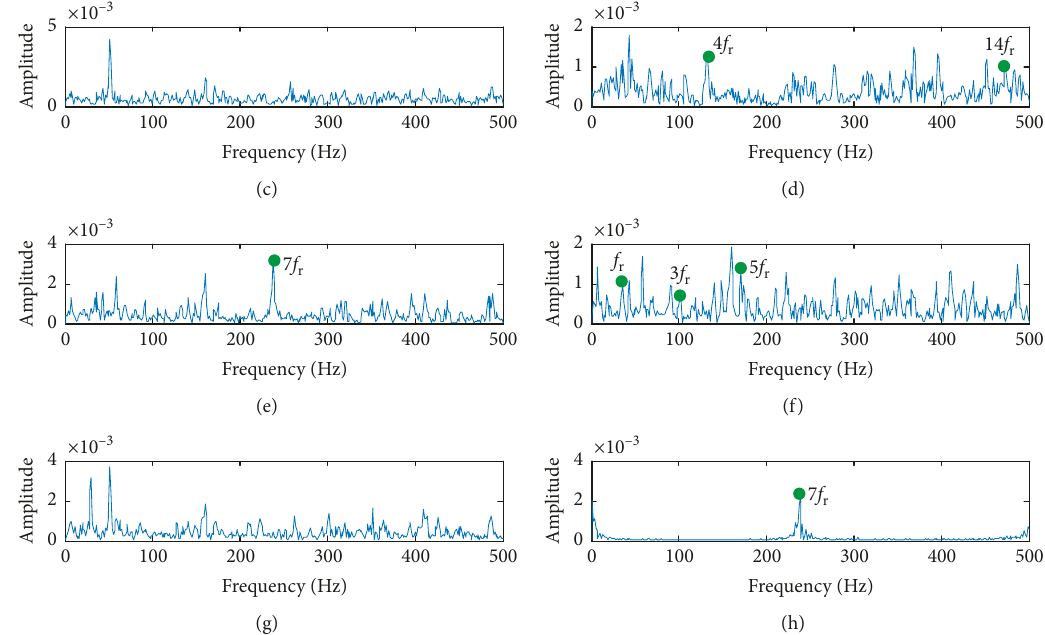
Figure 20: The Frequency domain diagram of multiresolution DMD modes of normal roller bearing signal, where (a)–(h) are corre- sponding to signals in Figure 17, respectively.